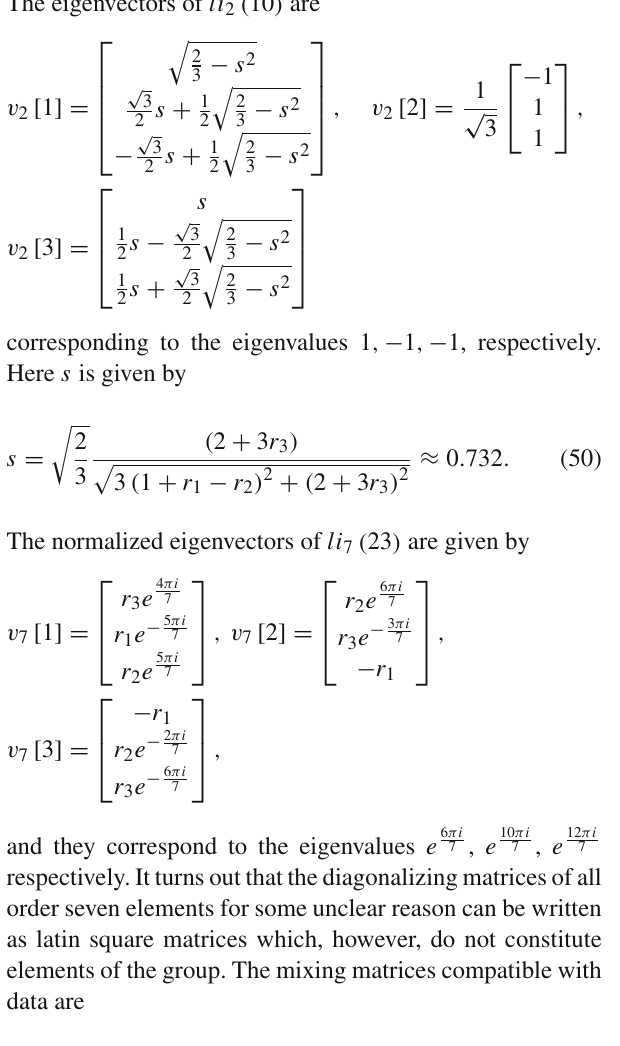
The eigenvectors of li 2 ( 10 )